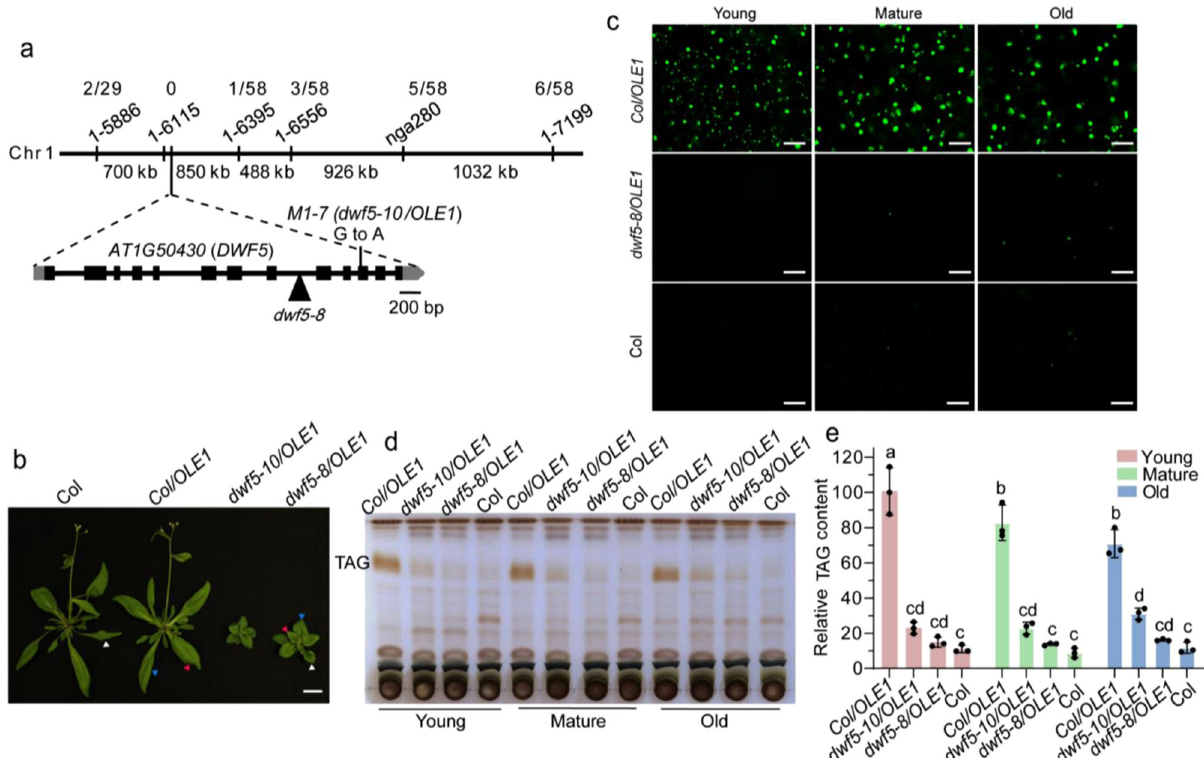
Fig. 2 Disruption of DWF5 results in defects in TAG and LD accumulation in leaves. a The map position of the M1-7 mutation and structure of DWF5 (At1g50430). Markers used for mapping and the respective number of recombinants are indicated. The exons of DWF5 are shown as black boxes and introns are indicated by lines. The point mutation in the dwf5 mutant allele is indicated with a line and the T-DNA insertion with a triangle. b Growth phenotypes of 4-week-old plants. Red, blue, and white arrowheads indicate young, mature, and old leaves (for de fi nitions, see Fig. 1), respectively. Bar = 2 cm. c Representative images of LDs (OLE1-GFP, green) in leaves of 4-week-old Col/OLE1 and dwf5-8/OLE1 plants and LDs in wild-type leaves stained by Nile Red. The experiment was repeated 4 times with similar results. Bar = 50 μ m. d , e , TLC analysis of neutral lipids. Lipids were extracted from leaves of 4-week-old plants and visualized with 5% sulfuric acid by charring ( d ). Relative contents of TAG were quanti fi ed by Image J ( e ). Data are mean ± SD of three biological replicates. Different letters indicate signi fi cant difference at P < 0.05, as determined by one-way ANOVA with Tukey ’ s multiple comparisons